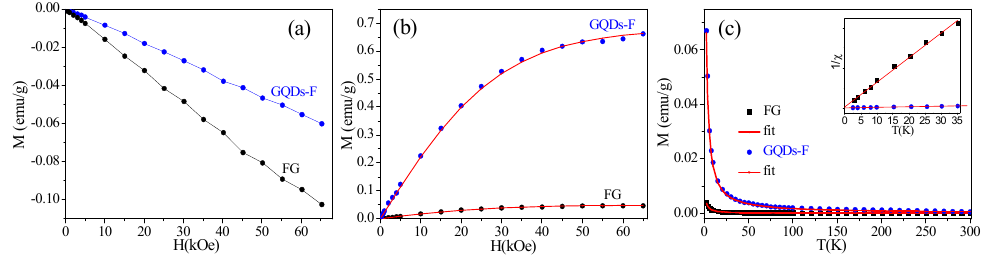
Figure 5. ( a ) The magnetization M ( H ) curves of FG and GQDs-F measured at 300 K by SQUID. It is found that both the samples exhibit linear diamagnetism at 300 K; ( b ) The initial M ( H ) of FG and GQDs-F measured at 2 K. Symbols are measured data, and the solid curves are fitted curves of Brillouin function; ( c ) The M ( T ) curves of FG, GQDs-F under an applied field of 3 kOe. Inset is the corresponding 1/ χ ( T ), and the solid lines are fitted lines of the Curie law.